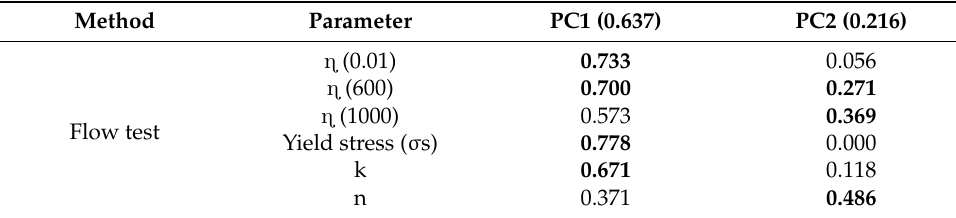
Table 5. Values of cos 2 for each parameter for the two axes of PCA flow test (the significant values are in bold.